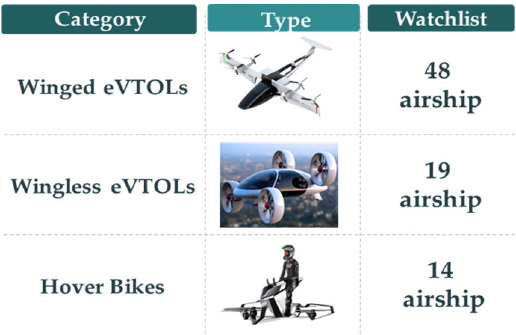
Figure 2. UAM classification by wing shape (https://transportup.com/ (accessed on 7 March